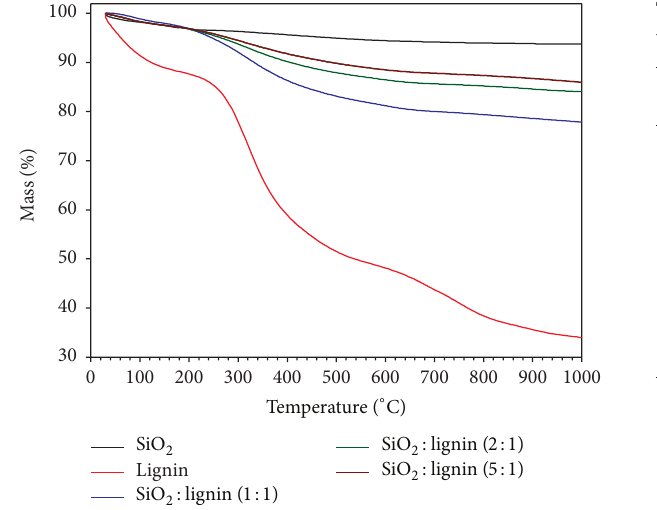
Figure 3: Thermal degradation curves versus temperature for pure silica and lignin as well as for silica-lignin hybrid fillers.